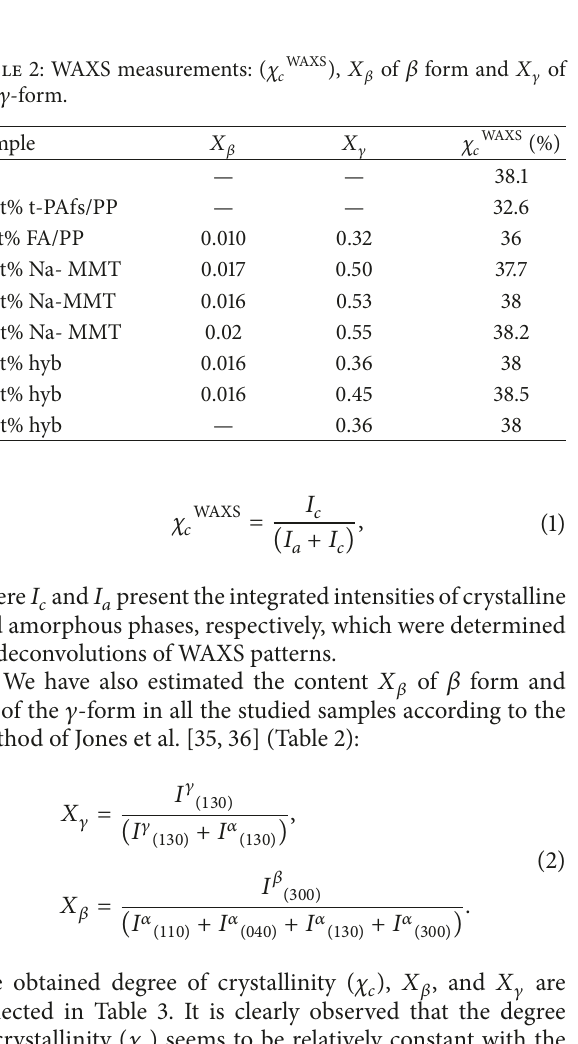
Figure 6: WAXS patterns of 5 wt% t-PAfs/3, 5, and 7wt% f-Na-MMT/PP hybrid composites.